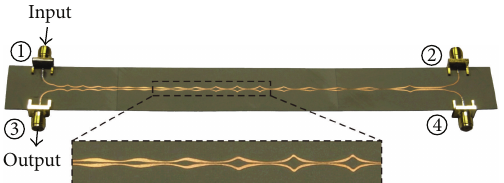
Figure 5: Photograph of the fabricated prototype of transmission- type dispersive delay line, indicating the input and output ports. A zoom-in is included to show a detail of the device. The ground plane is unaltered.